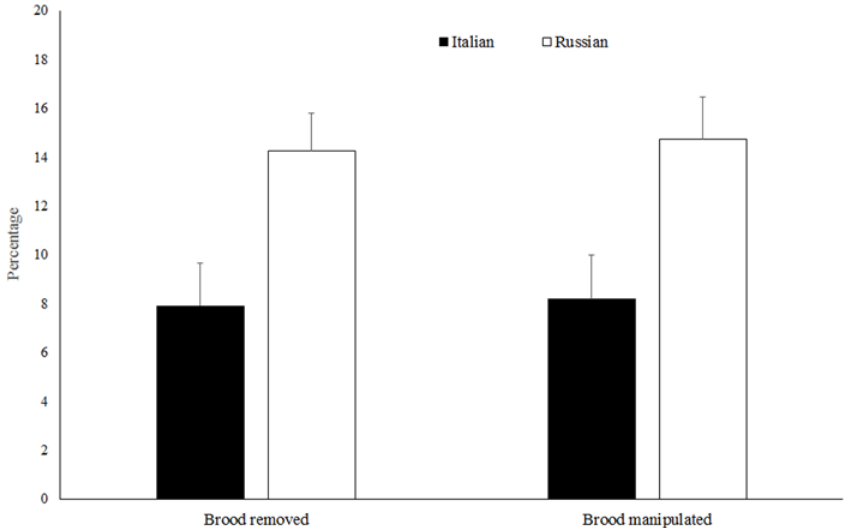
Fig 3. Percentages of brood removed and manipulated by Italian and Russian honey bee colonies in test brood sections of donor combs.